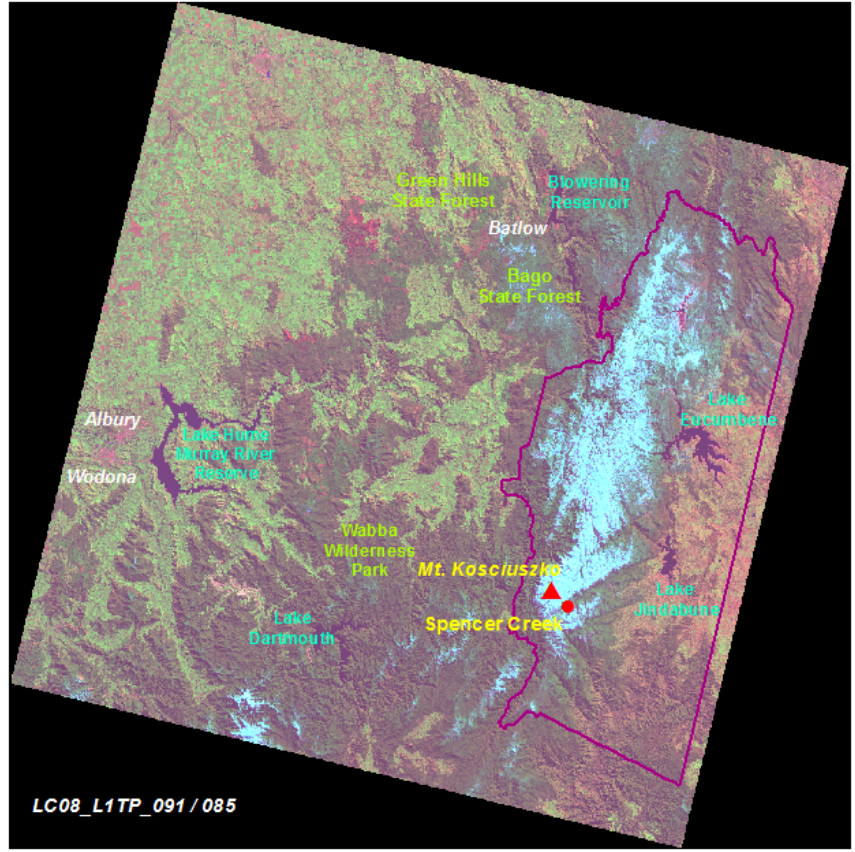
Figure 2. A sample Landsat image with maximum snow cover and a few well-recognized geographic features, adjusted to the study area boundary.